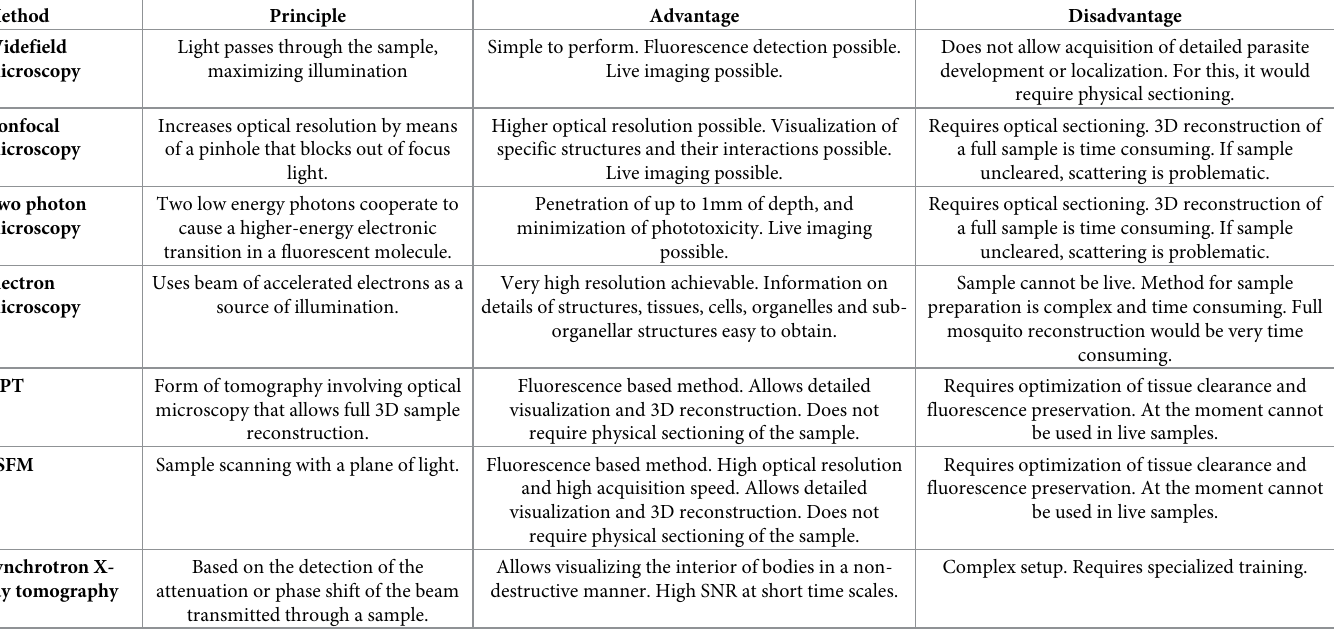
Table 2. Comparison of OPT/LSFM with other microscopy